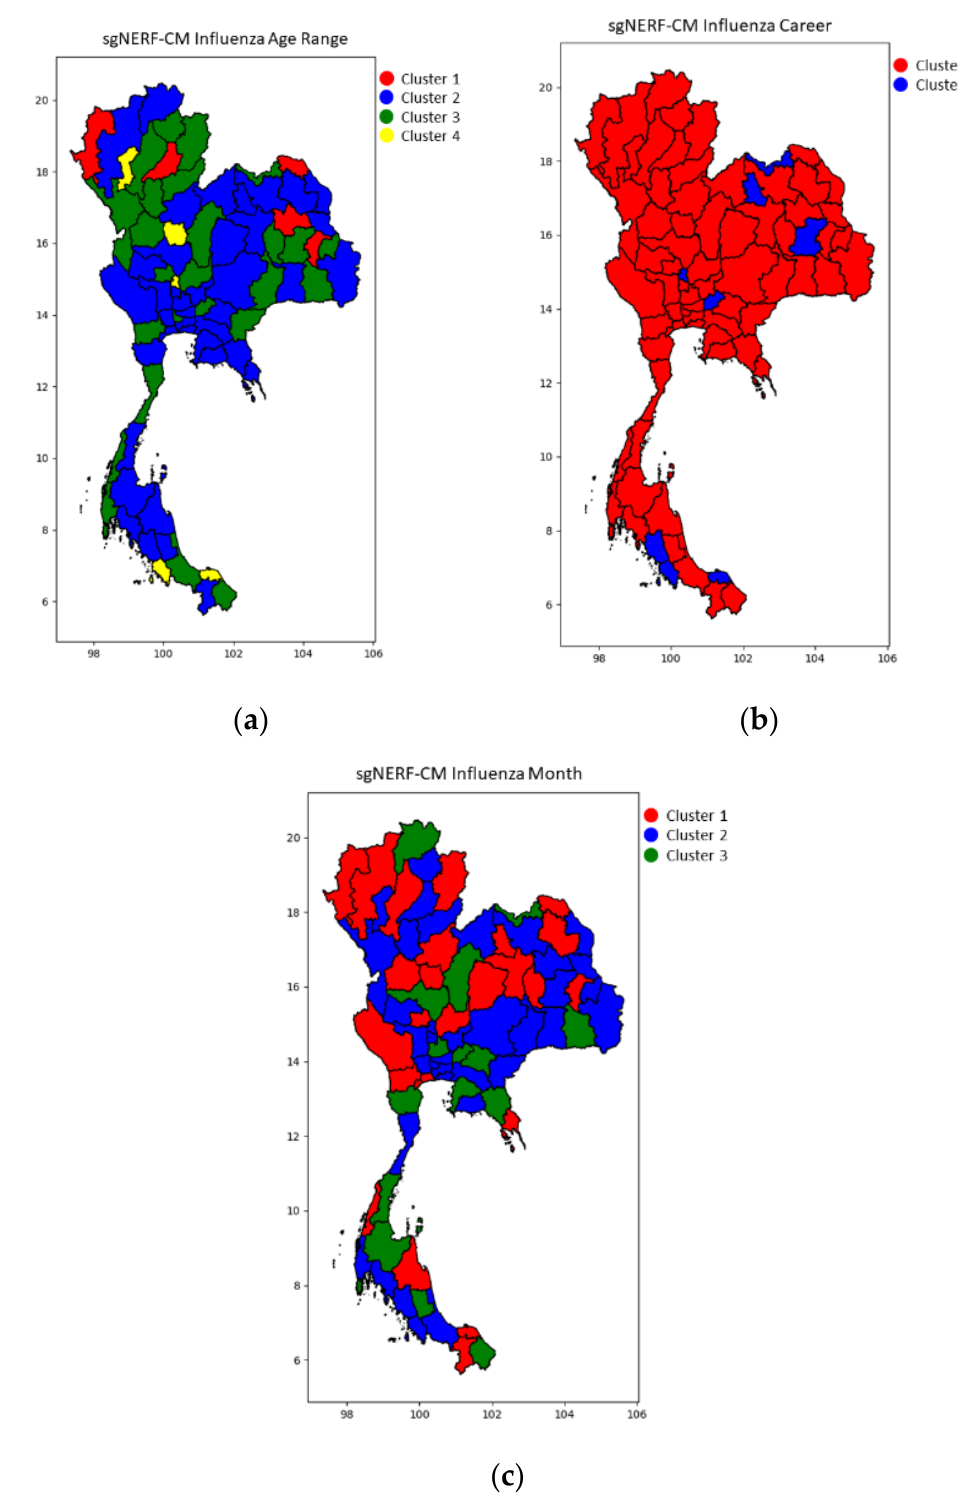
Figure 3. The blind test results for the influenza dataset for ( a ) age range, ( b ) career, and ( c ) month category using the best models from sgNERF-CM algorithm.